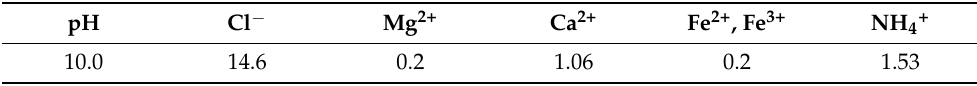
Table 1. Chemical composition of the tested district heating water (mg · L − 1